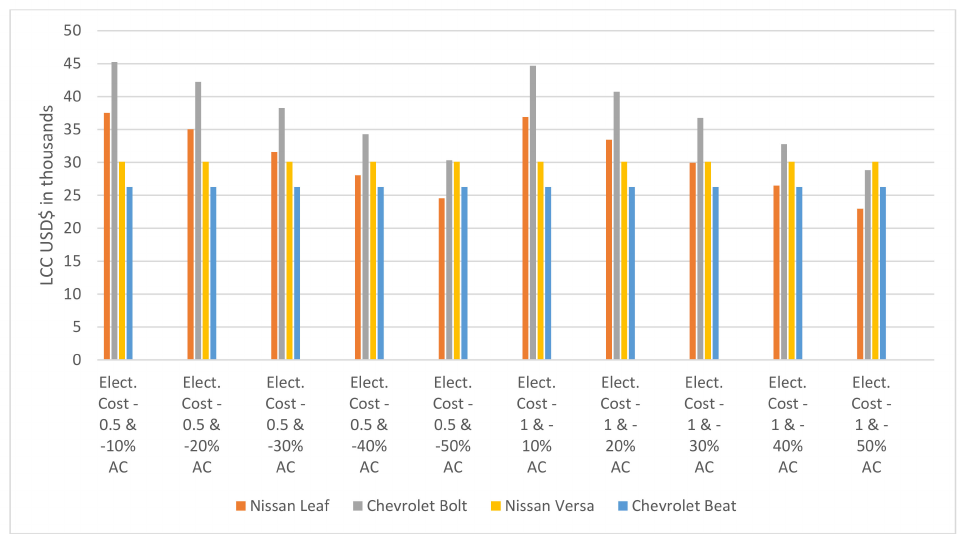
Figure 8. Comparison of LCC values in terms of the AC cost percentage and electricity cost